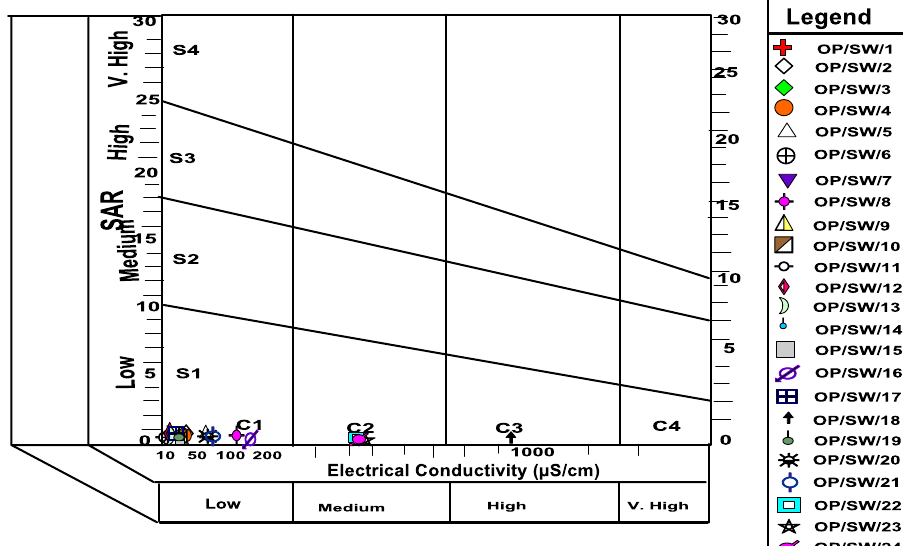
Fig. 5 Classification of Water based on US salinity diagram (after Richards